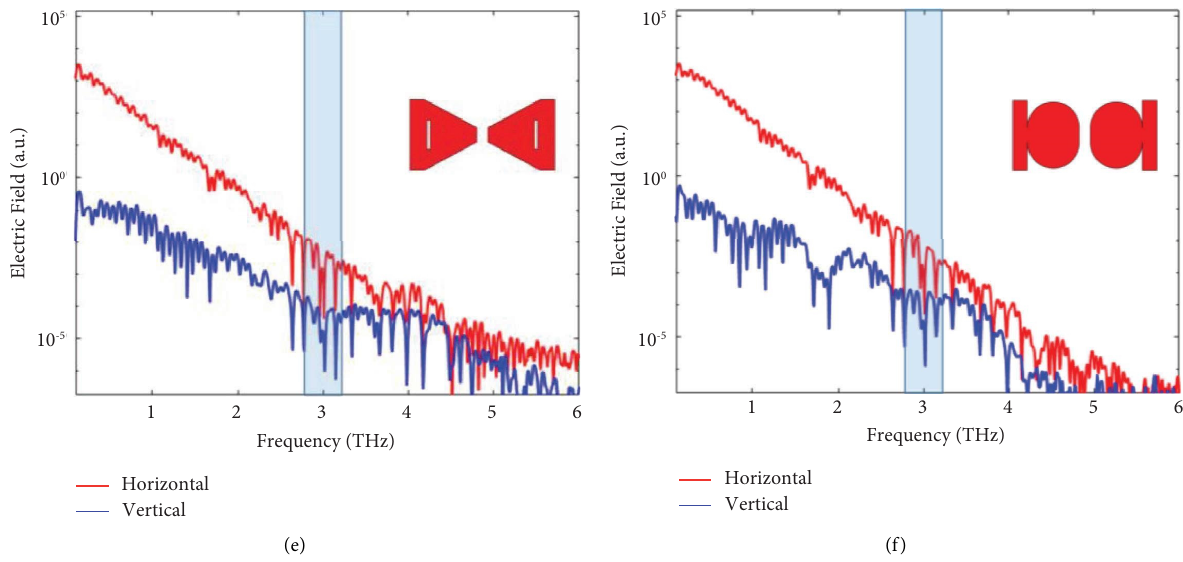
Figure 9: Experimental measurements of antenna polarization using two wire polarizers and a half-wave plate x-cut quartz crystal: (a) 3D experiment confguration, (b) commercial THz antenna from TeraView Ltd., (c) bowtie, (d) fractal, (e) sotted, and (f) circular, antennas. Te dimensions of Figure 9(a) are not to scale, as the antennas are in micrometers, while the polarizers and the crystal are in